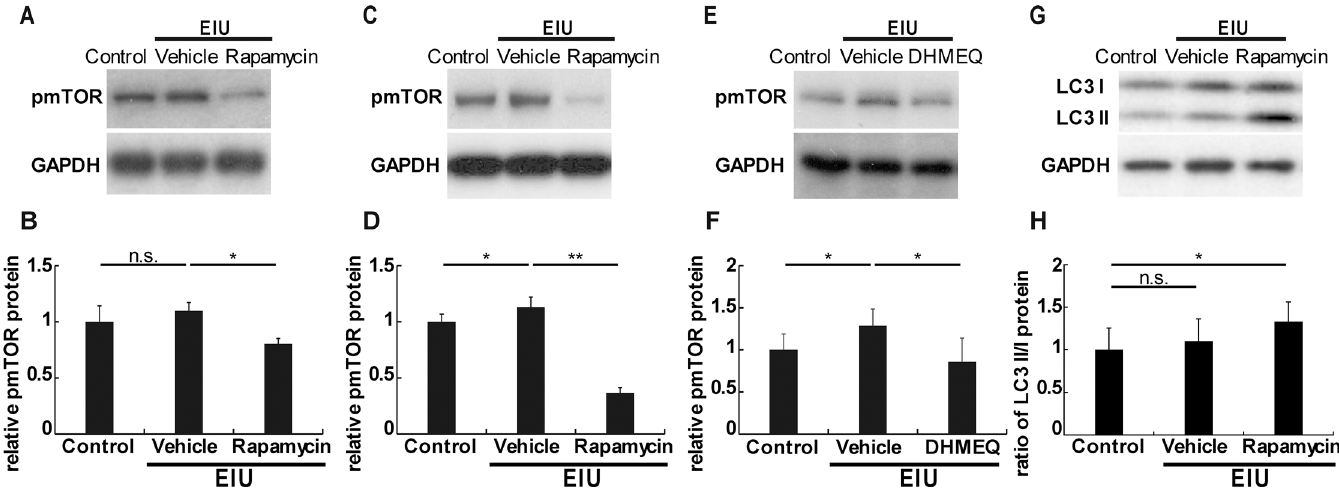
Fig 5. The interaction between mTOR and NF- κ B in the retina during inflammation. Immunoblot analyses (A-H). The protein level of phosphorylated and activated mTOR (pmTOR) was not increased in the retina 3 hours after the induction of inflammation by an intraperitoneal lipopolysaccharide (LPS) injection, although the level of pmTOR was suppressed by the rapamycin treatment (A, B). At 12 hours after the LPS injection, the pmTOR expression was increased in the retina, which was suppressed by the rapamycin treatment (C, D). The pmTOR level in the retina at 12 hours was also suppressed by the NF- κ B inhibitor, DHMEQ (E, F). The ratio of the LC3II to LC3I protein levels (an autophagy marker) in the retina was not changed after LPS injection but was increased by rapamycin at 12 hours after LPS injection (G, H); n = 5. * p < 0.05, ** p < 0.01.